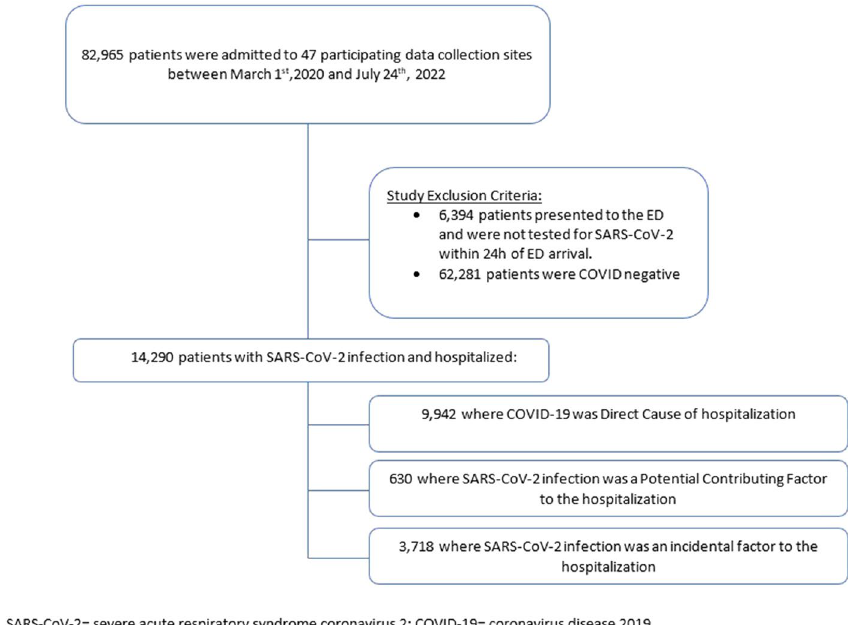
Figure 1. Participant flow